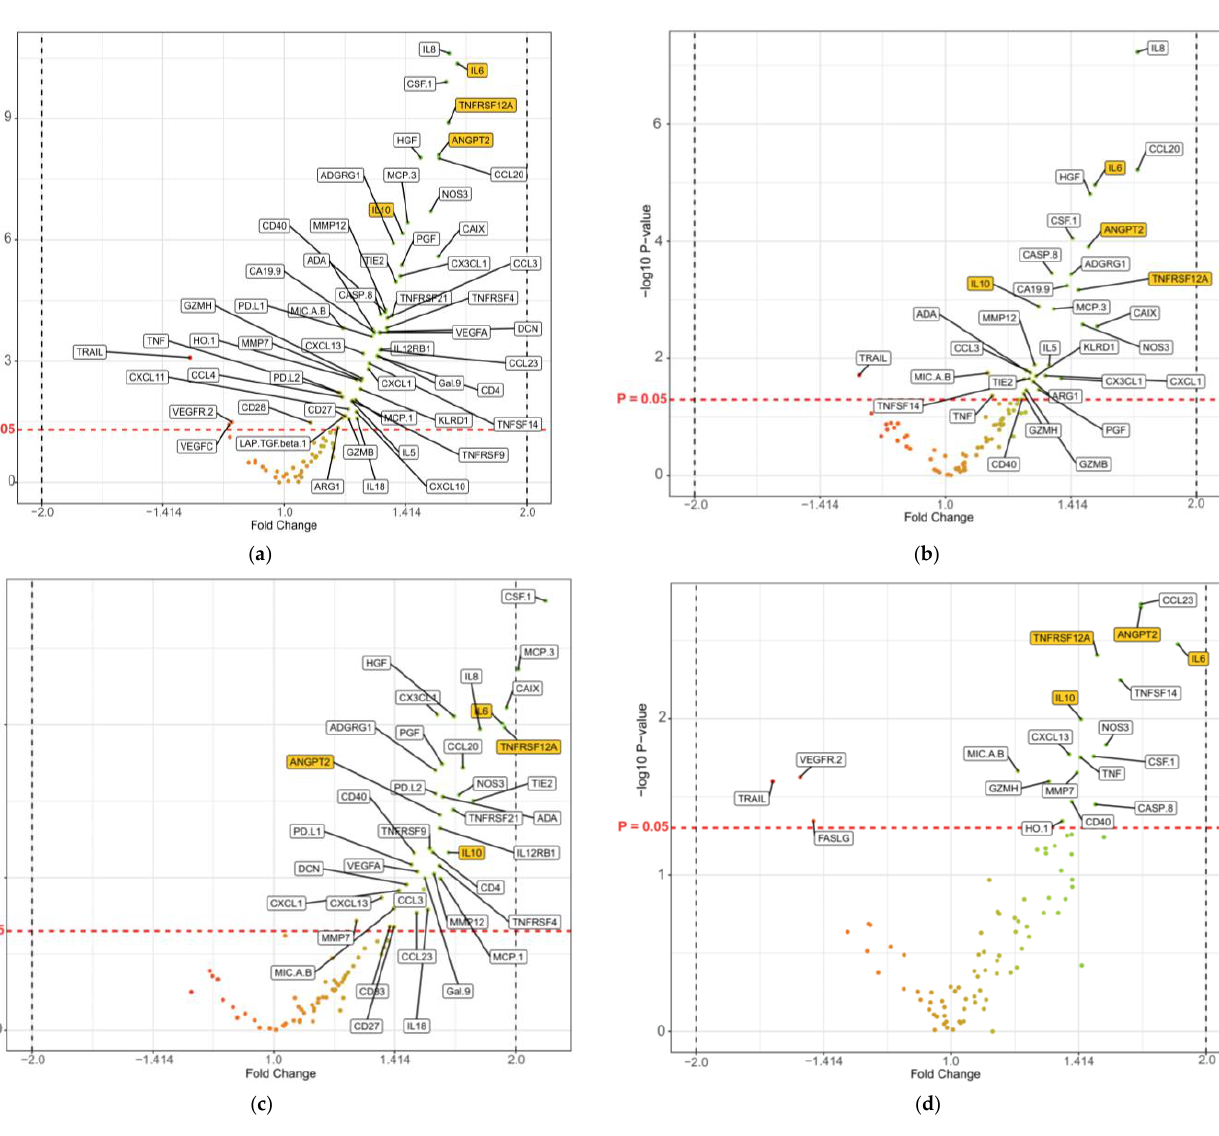
Figure 4. Volcano plots of the comparison of circulating-protein levels in all patients divided by survival groups ( ≤ 180 days vs. >180 days) and treatment subgroups. The relationship between non-adjusted − log10 p values is described on the y -axis and fold changes on the x -axis for the proteins. Proteins with significant non-adjusted p values ( p < 0.05) are labelled with abbreviated names. The horizontal red dashed line represents p = 0.05. The x-axes represent the fold change between protein levels in the survival groups (≤180 days vs. >180 days). An example is I L-10 in Figure 4a, which has a fold change of approximately 1.4, meaning that the IL-10 NPX- values in patients surviving ≤ 180 days is approximately 1.4 times higher than in patients surviving >180 days. The x-axes have been modified from a log2 scale. ( a ) All patients divided into survival groups of ≤ 180 days ( n = 135) and >180 days ( n = 228); ( b ) patients treated with gemcitabine (survival ≤ 180 days ( n = 78) vs. >180 days ( n = 105)); ( c ) patients treated with gemcitabine + nab-paclitaxel (survival ≤ 180 days ( n = 34) vs. >180 days ( n = 48)); and ( d ) patients treated with mFOLFIRINOX (survival ≤ 180 days ( n = 23) vs. >180 days ( n = 75).